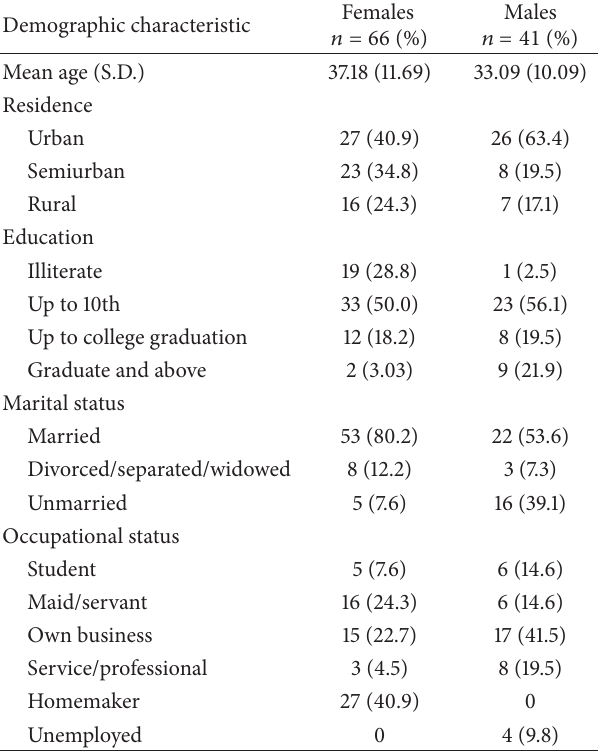
Table 1: Sociodemographic characteristics of the 107 patients with